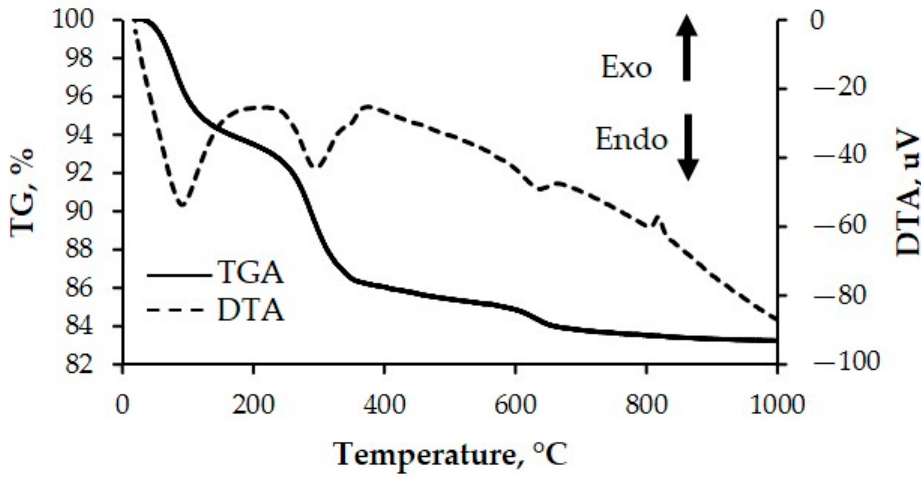
Figure 3. TGA-DTA thermograms of NMW sample.